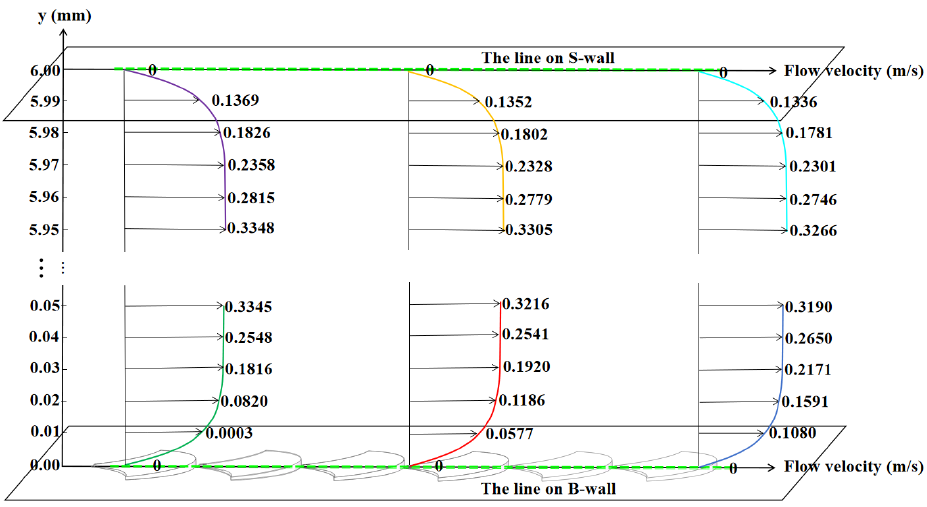
Figure 14. Velocity distribution near the wall.